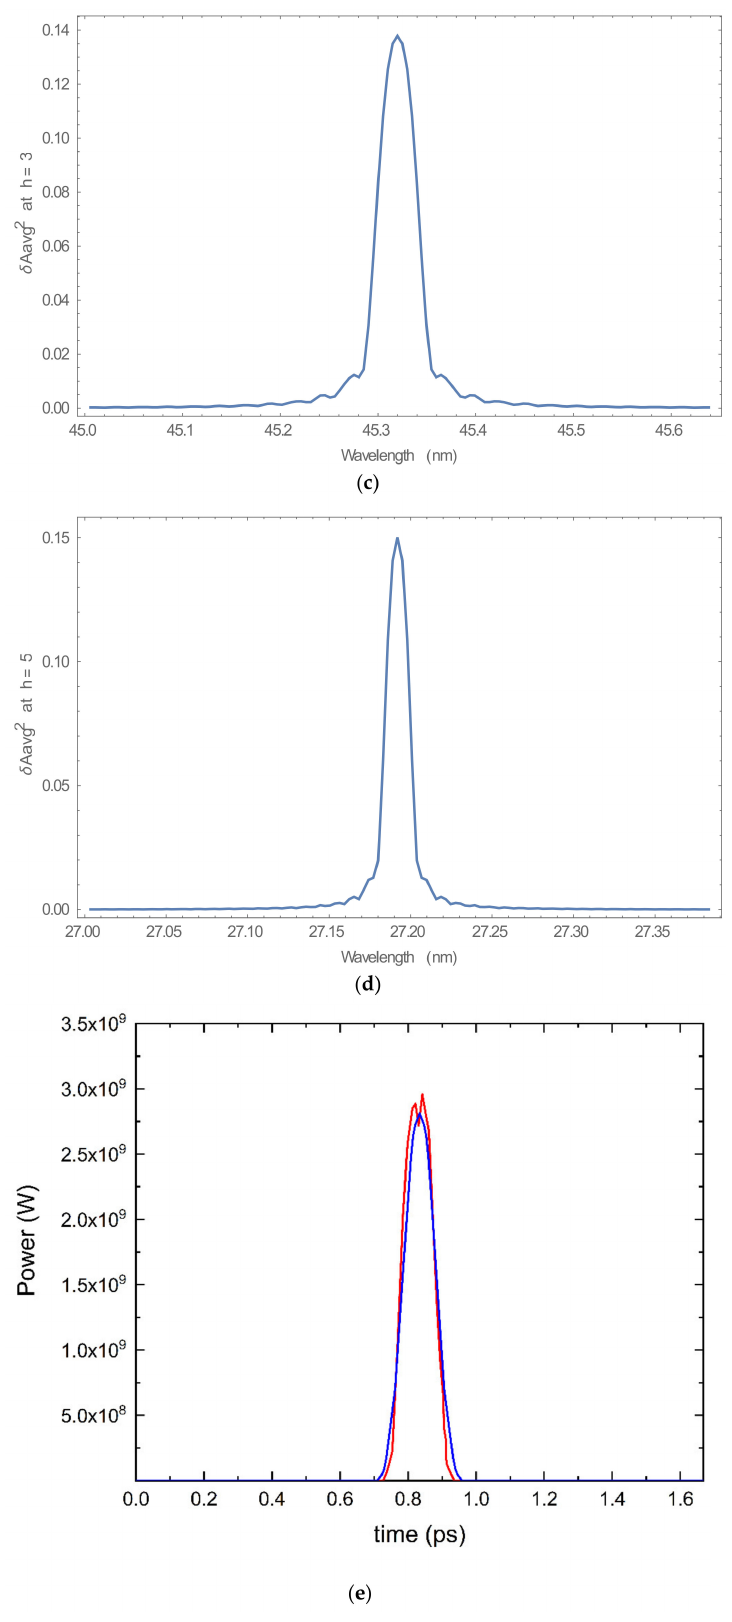
Figure 8. The evolution of the field intensity of polarized radiation for the wavelength with axial distance for the fundamental and higher-order modes of ( a ) h = 1 (Genesis), ( b ) h = 1, ( c ) h = 3, ( d ) h = 5, and ( e ) h = 1 (4GLS) modes in the single-beam